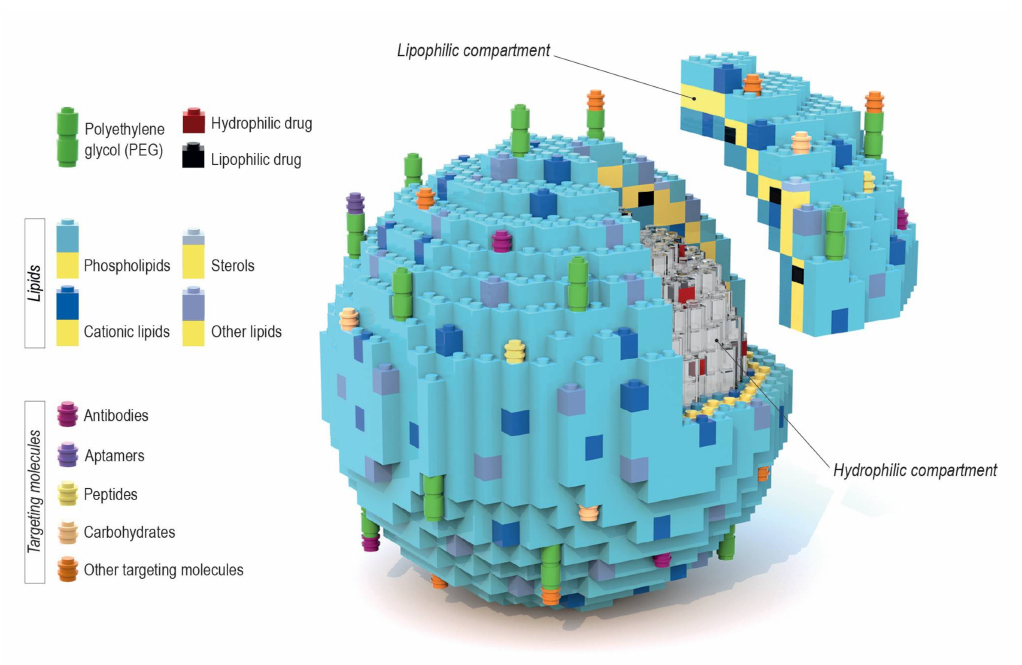
Figure 1. Schematic representation of a variety of liposome drug carriers’ composition, where each component is depicted as a Lego block. The liposomal envelope consists of a lipid bilayer that creates an environment for solubilizing lipophilic drugs. Inside of the liposome is an aquatic core where potential hydrophilic drugs can be entrapped. The block-like nature of this model allows for the easy engrafting of targeting particles (either directly or via polyethylene glycol (PEG)) to the liposomal surface. The modular nature of liposomal components is particularly clear in the case of formulations described in Section